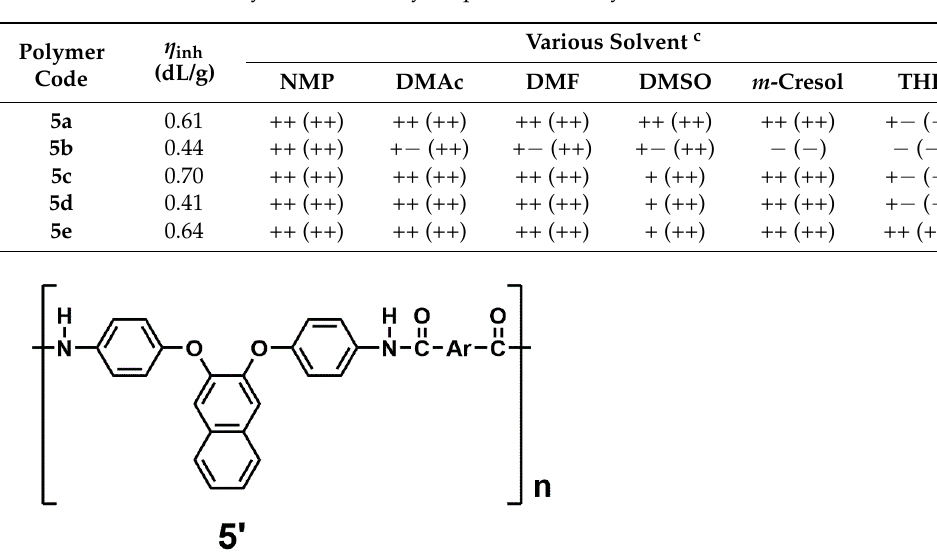
Table 1. Inherent Viscosity a and Solubility Properties b of Polyamides.